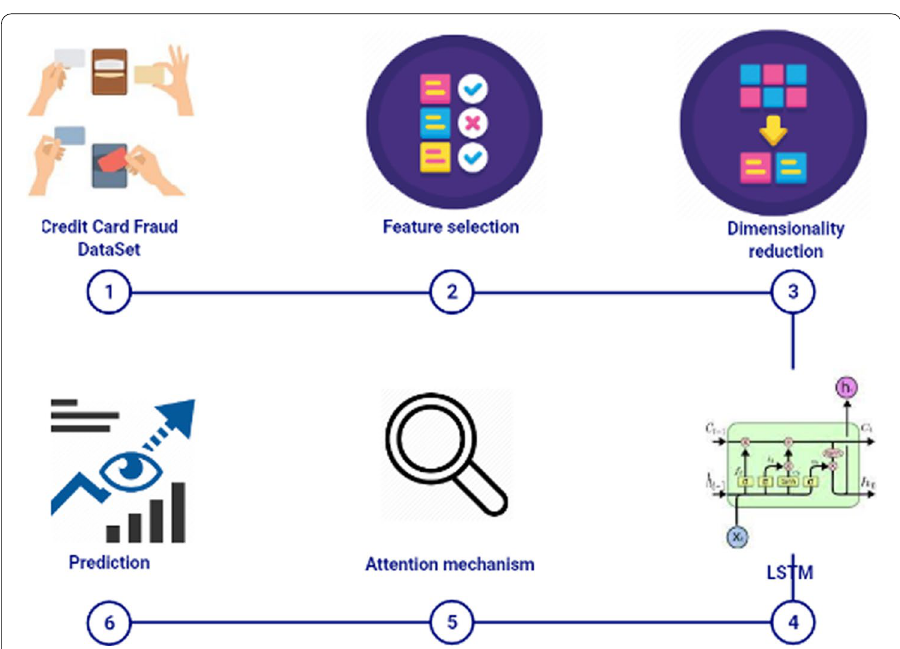
Fig. 4 The architecture of the proposed credit card fraud detection model